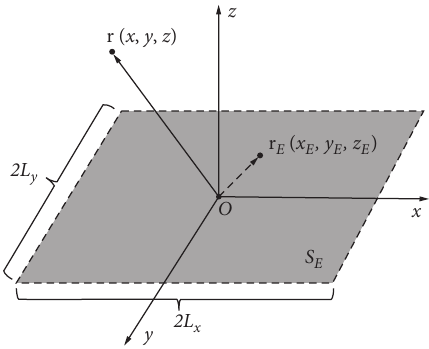
Figure 1: Field point and source